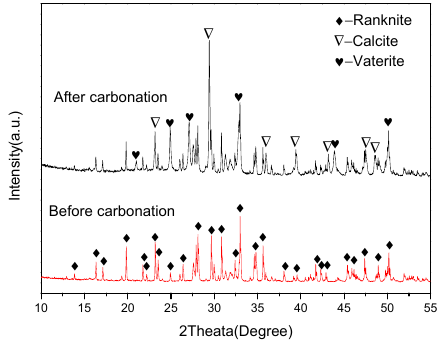
Figure 2. X-Ray Diffraction (XRD) patterns of the C 3 S 2 phase before carbonation and carbonated for 24 h.